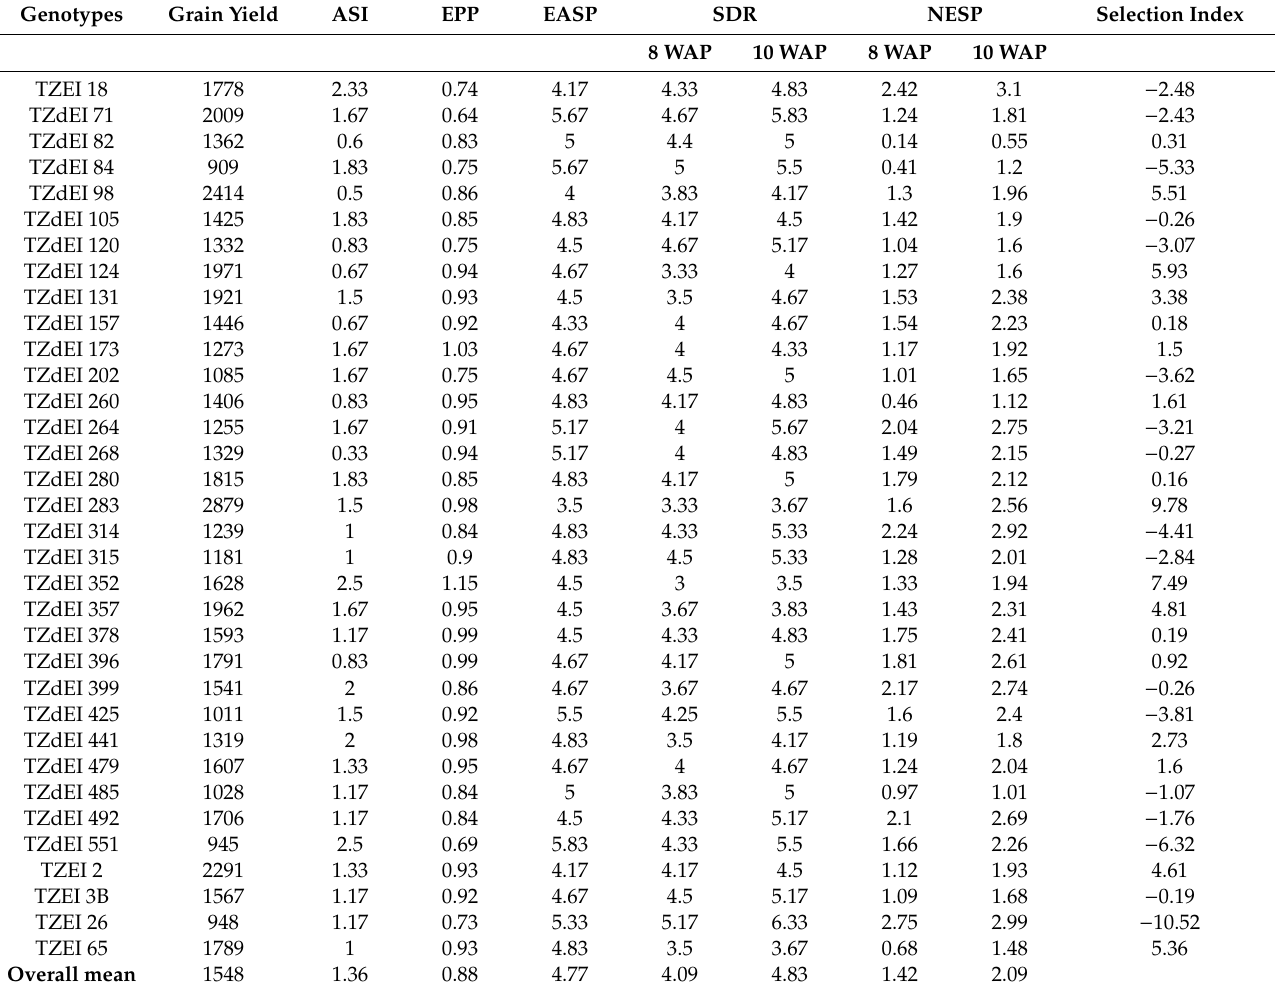
Table 2. Mean performance of 36 early maturing white inbred lines evaluated under Striga infestation (at Mokwa in 2014 and 2015, and Abuja in 2015) in